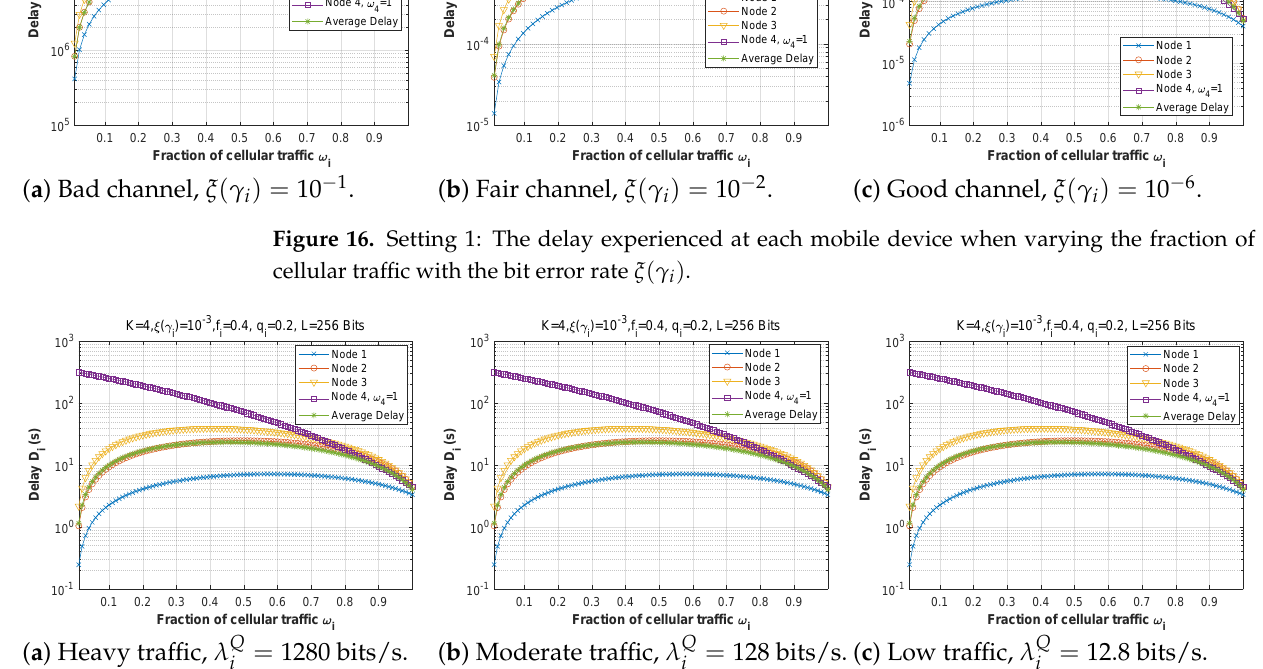
Figure 17. Setting 1: The delay experienced at each mobile device when varying the fraction of cellular traffic with the arrival rate λ Q i